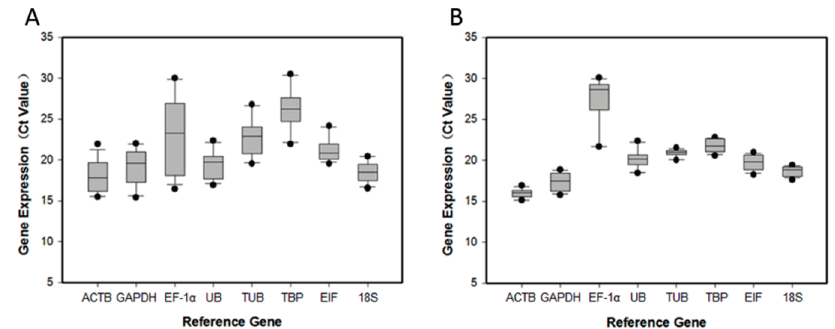
Figure 1. Expression levels of candidate reference genes under different experimental conditions. The expression levels of candidate reference genes in eight different tissues ( A ) and six different ovarian developmental stages ( B ) are displayed as cycle threshold ( C t ) values. The median is indicated by the line in the box. The interquartile range is bordered by the upper and lower edges, which indicate the 75th and 25th percentiles, respectively. The whiskers are inclusive of the maximal and minimal values, but exclusive of the outliers, which are represented by circles.